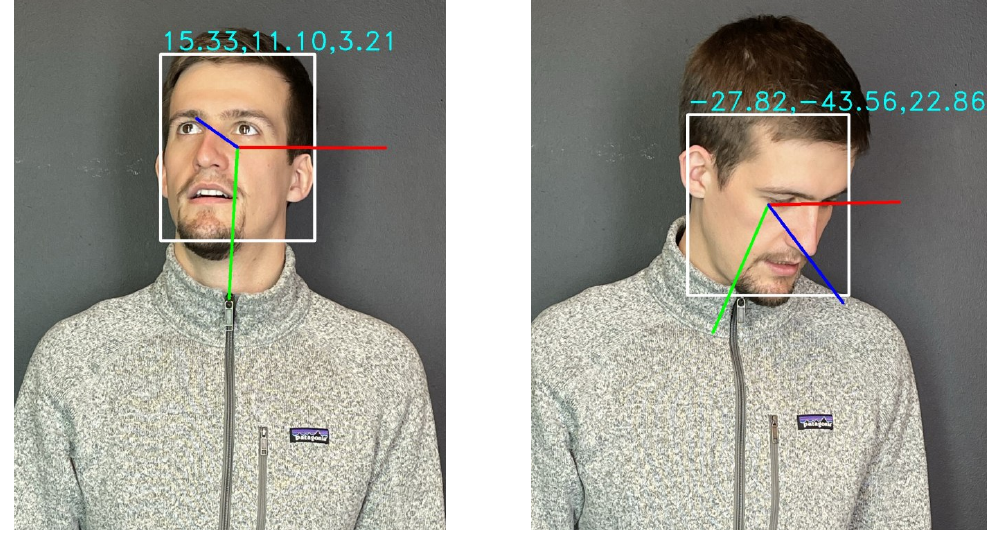
Figure 13. Head pose